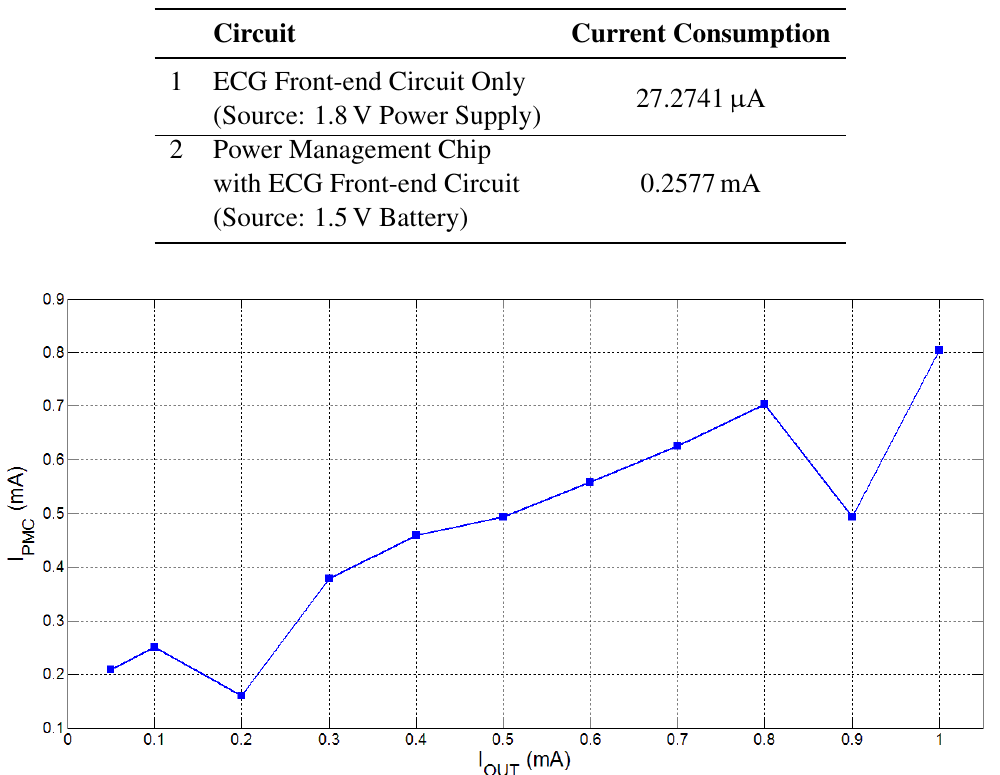
Figure 11. Power consumption of the power management chip for different load currents while regulating the output voltage, V